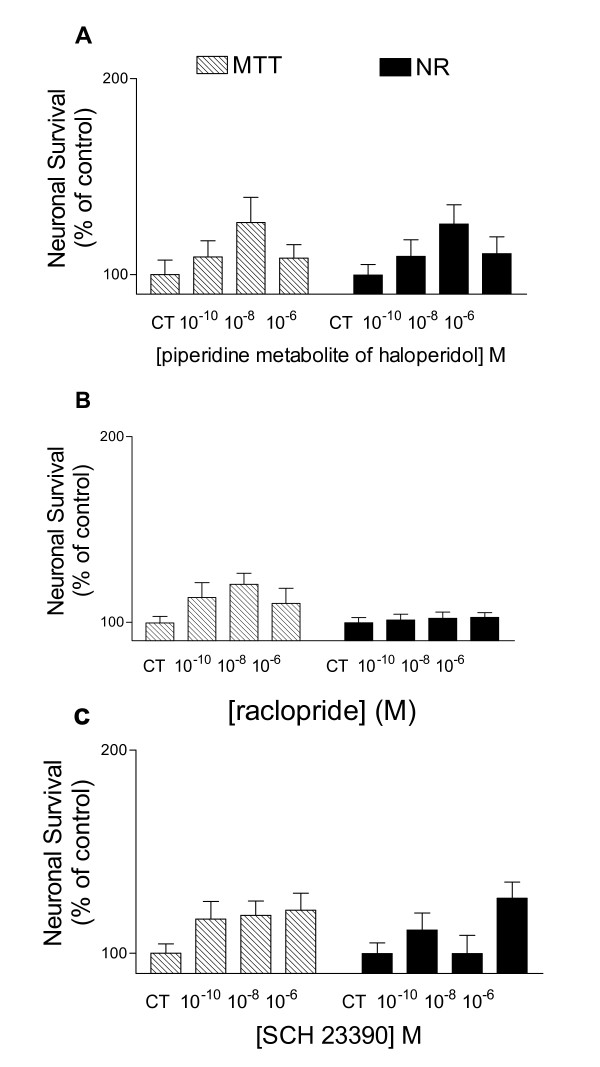
Effects of piperidine metabolite of haloperidol (A), raclopride (B) and (+)-SCH 23390 (C) against toxicity induced by growth medium deprivation in enriched hippocampal neuronal cultures. Neuronal survival is estimated using the MTT and neutral red (NR) colorimetric assays. Values represent mean ± SEM of at least three separate experiments, each performed in quadruplicate.